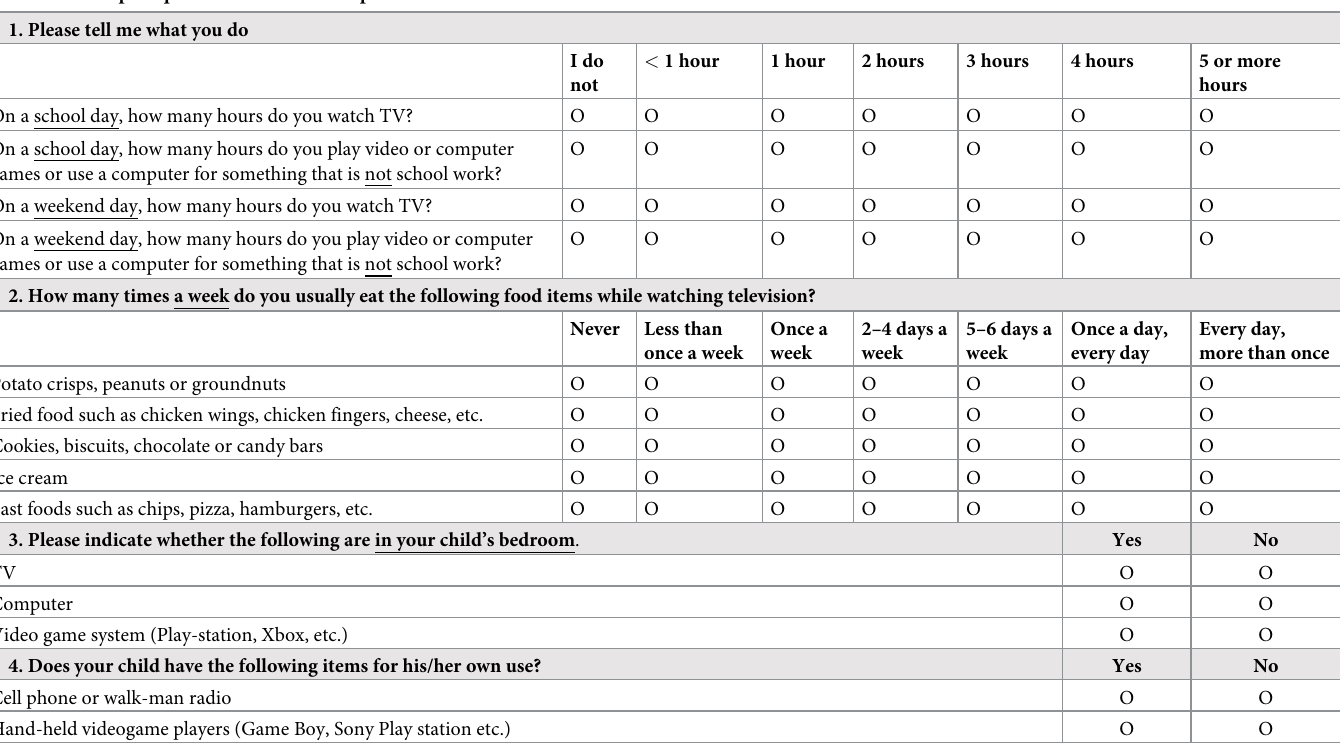
Table 1. Self-report questions and the list of possible